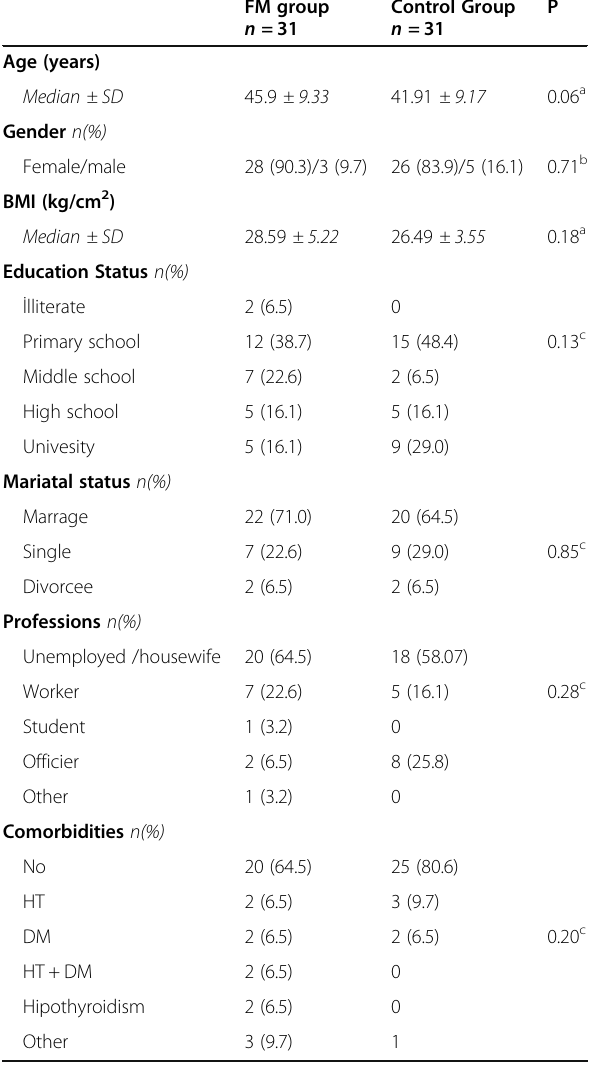
Table 1 Comprasion of general characterristics of participants between two